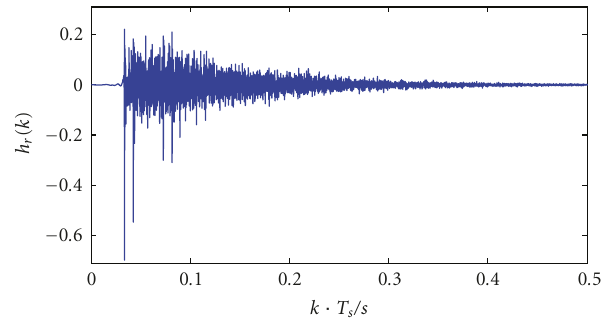
Figure 2: Measured RIR with T 60 = 0 . 79 seconds.